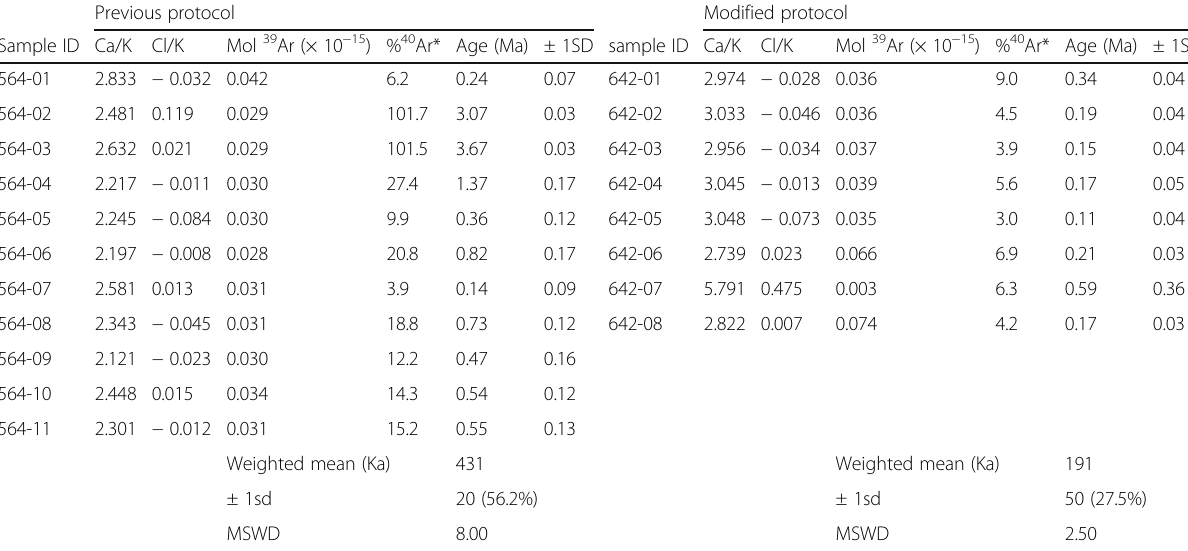
Table 3 Age data for the multiple aliquots of basaltic rock using the modified protocol Previous protocol Modified